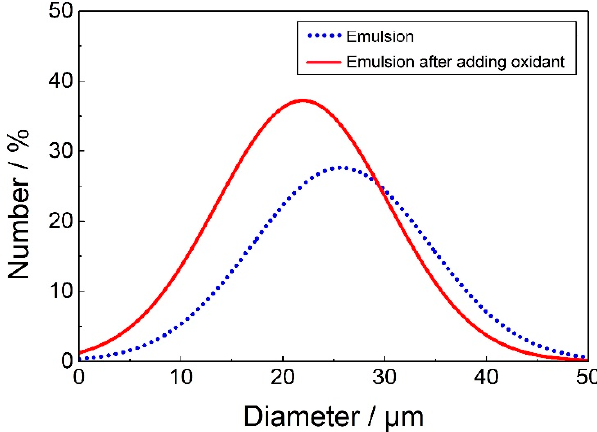
Figure 9. Droplets size distribution of the Pickering emulsion before and after redox